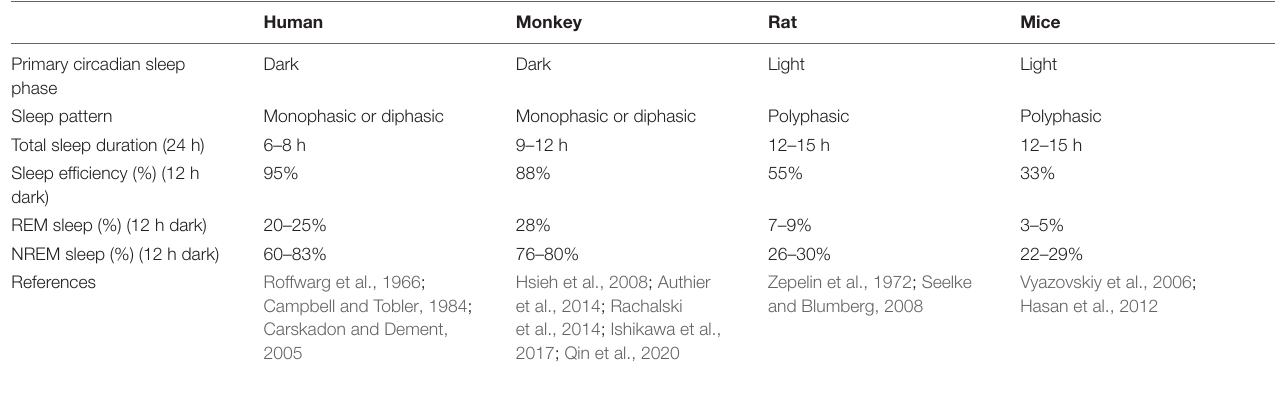
TABLE 3 | Different sleep pattern between human and